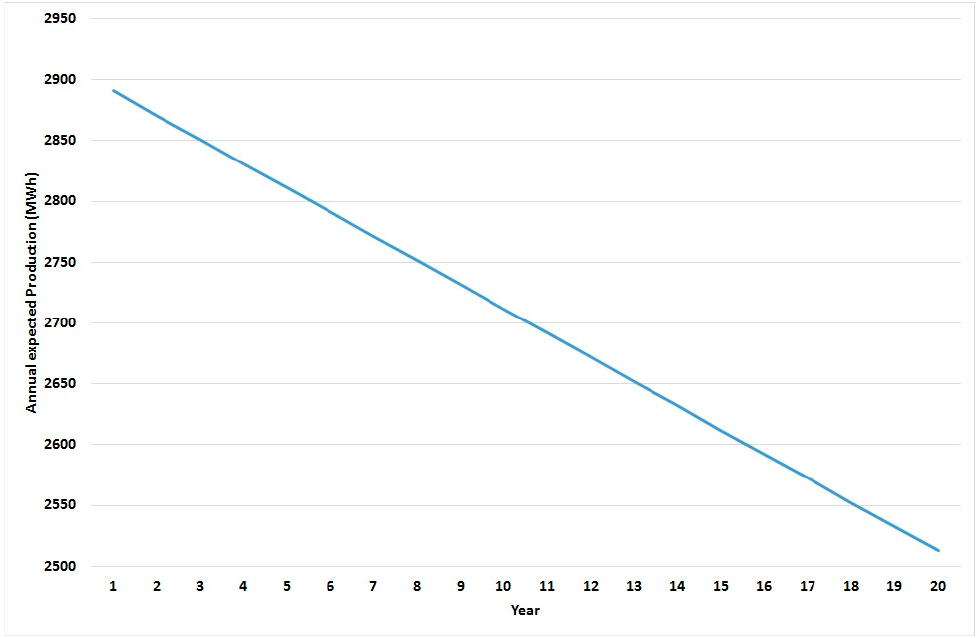
Figure A3. Expected yearly production (MWh) per MW installed.